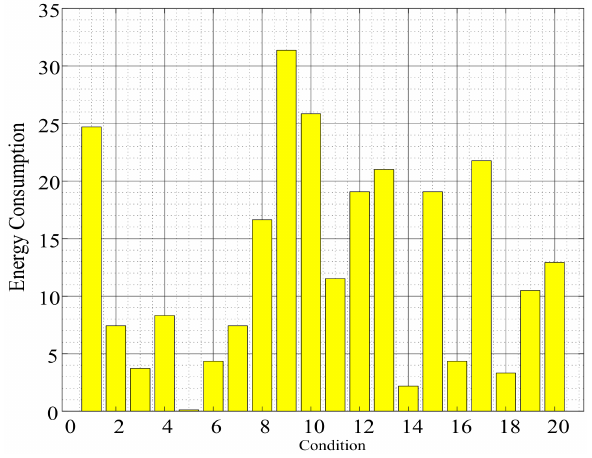
Figure 13. Energy for second line condition.